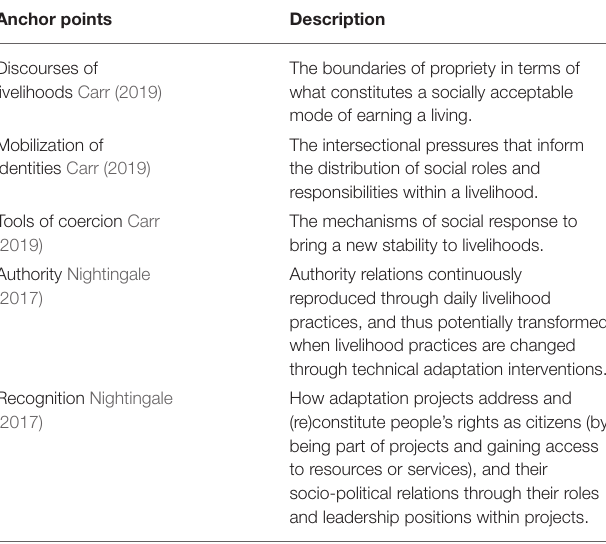
TABLE 1 | Conceptual anchor points for analysing gender relations in CSA